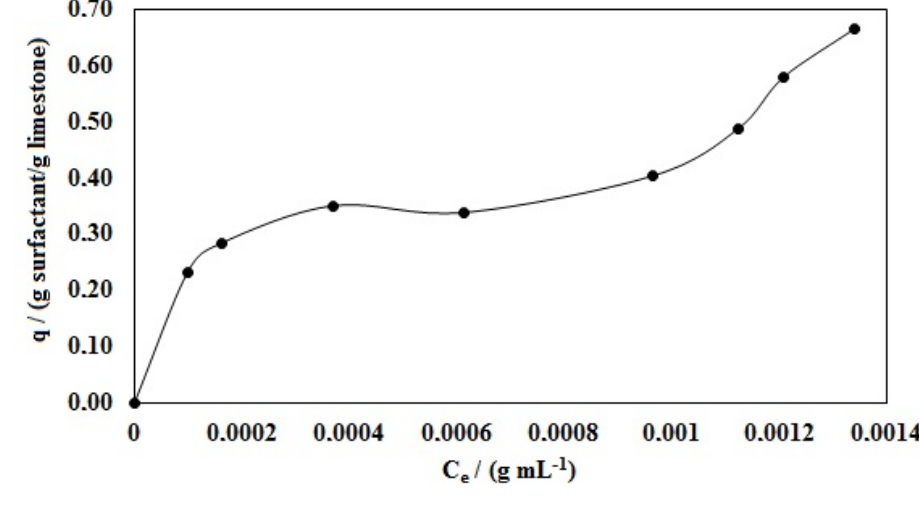
Figure 5. Adsorption isotherm obtained by varying SCO concentration at 30